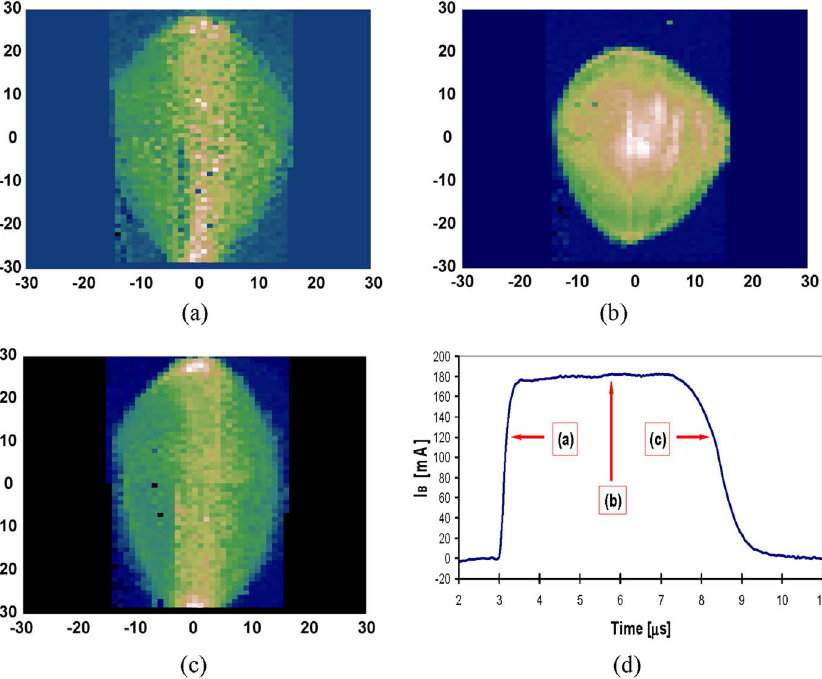
FIG. 21. (Color) Beam current density profiles J (cid:6) x; y (cid:7) at QD1 for the 80% fill factor case. (a) Head of the beam ( 0 : 36 (cid:2) s after * ); (c) tail of the beam ( 5 : 04 (cid:2) s after * ; (d) injector beam current waveform showing the total beam (b) midpulse ( 3 : 12 (cid:2) s after * 0 0 current and locations in the pulse for the density profiles in (a)–(c). Time jitter is responsible for the noisier pictures in (a) and (c), which were taken over 4000